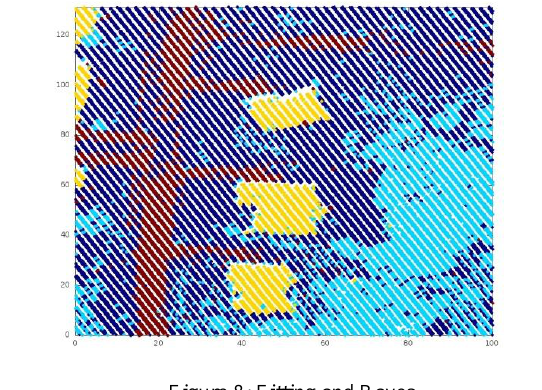
Figure 8: Fitting and Bayes